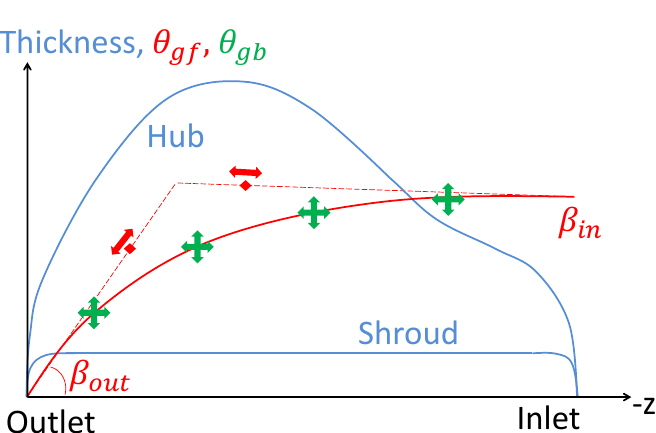
Figure 3. Thickness and θ